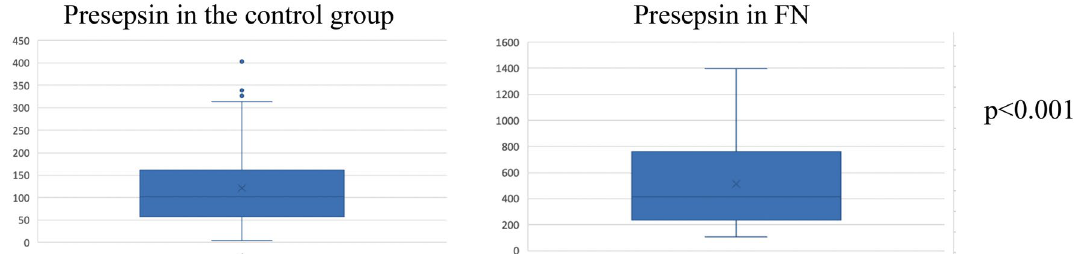
Figure 1. Median values of presepsin in the control group and in the FN group at T0. Figure shows presepsin values found in the control group and in the FN group.